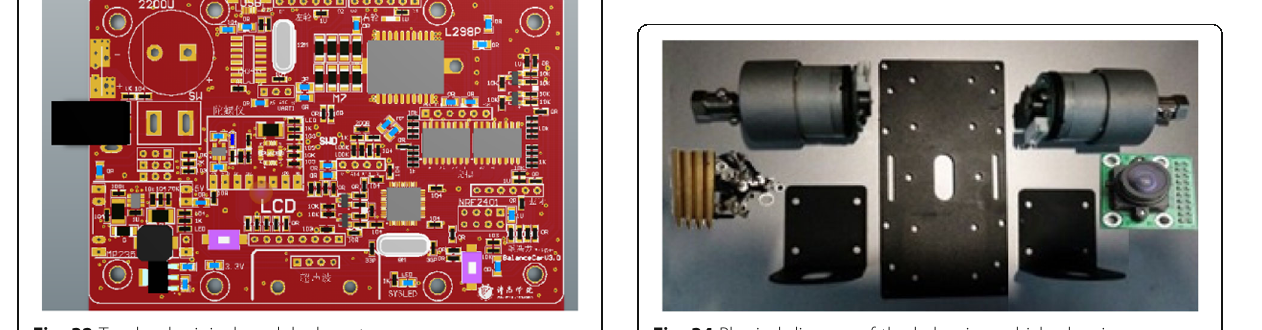
Fig. 32 Top-level original modular layout